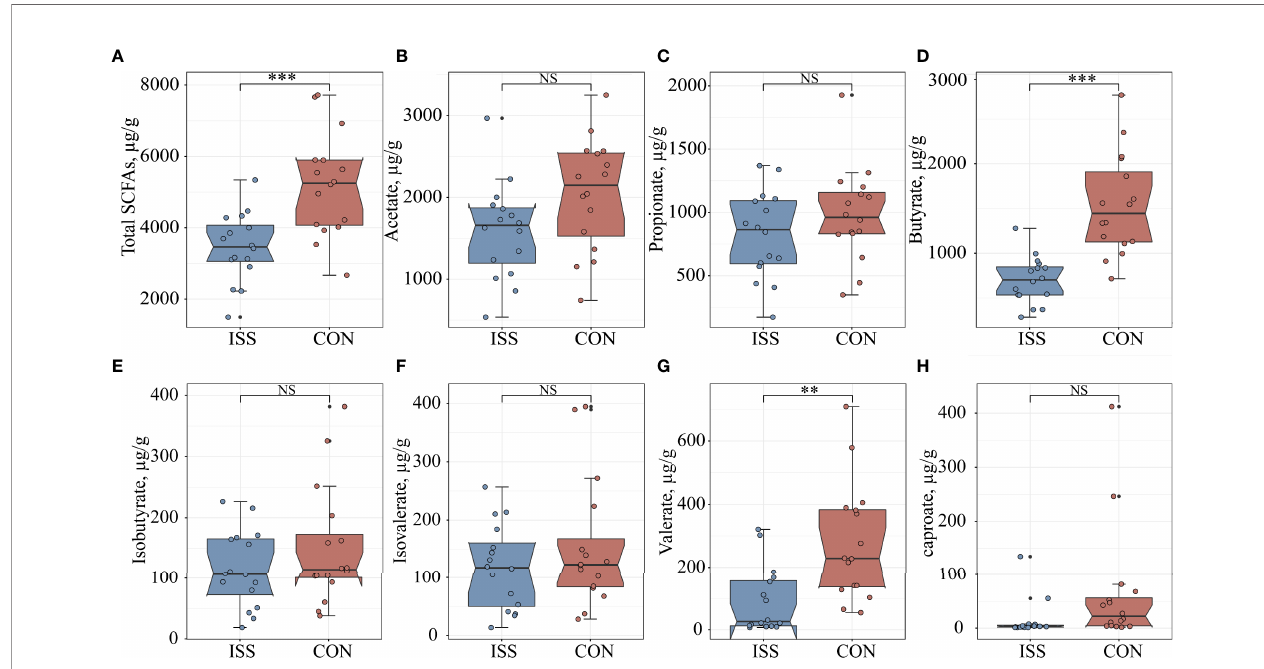
FIGURE 4 | Comparison of seven fecal SCFA levels between ISS patients and healthy controls. (A) total SCFAs; (B) acetate; (C) propionate; (D) butyrate; (E) isobutyrate; (F) isovalerate; (G) valerate; (H) caproate. ** P < 0.01; *** P < 0.001. NS, no signi fi